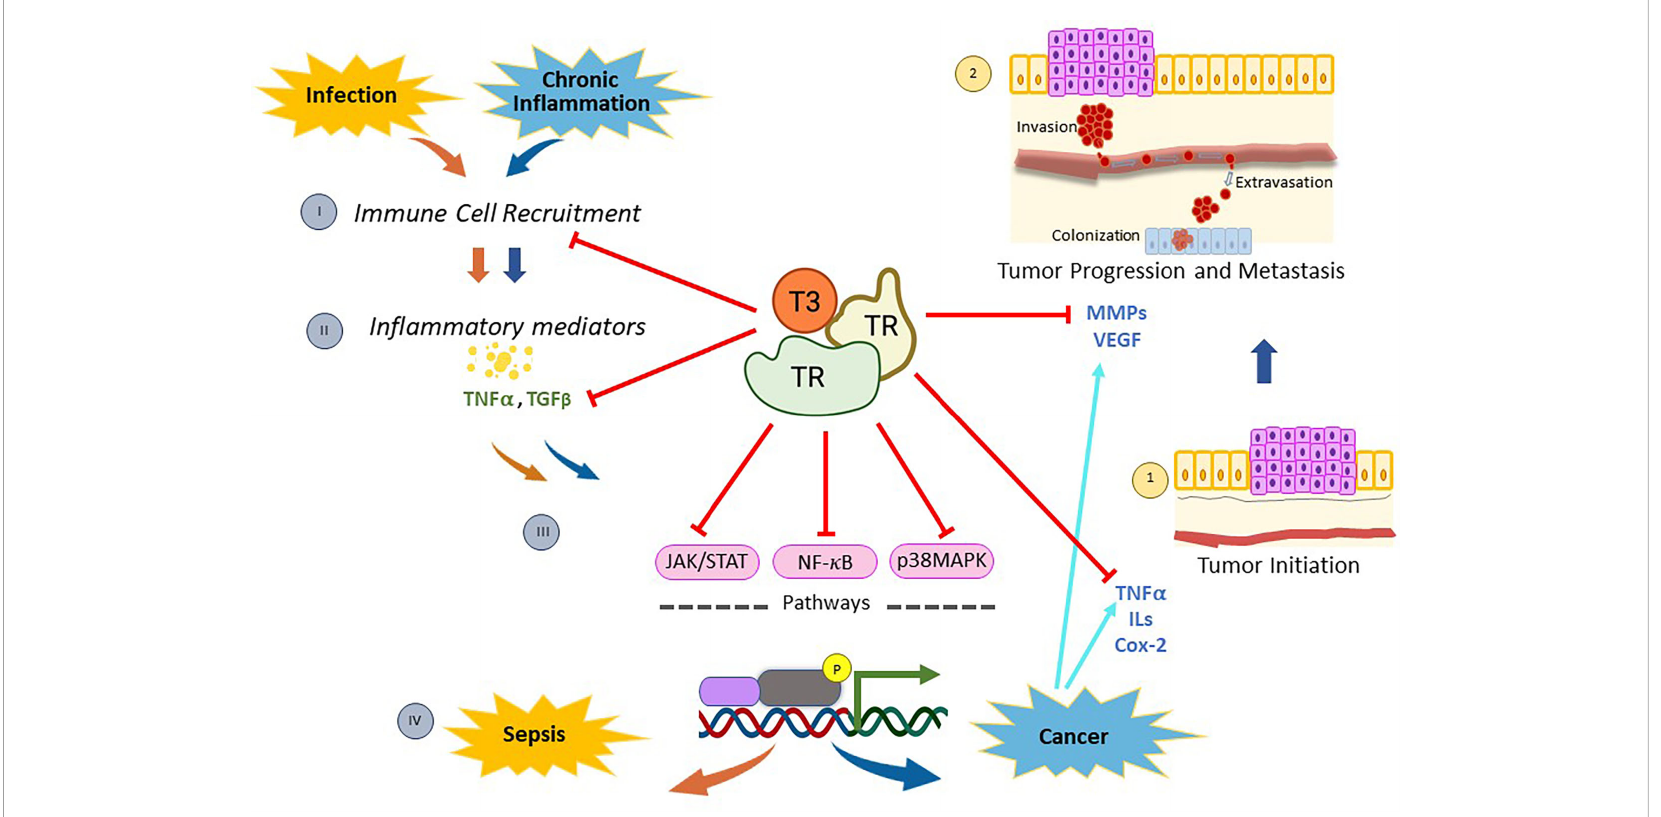
FIGURE 1 Mechanisms of action of thyroid nuclear receptors activated by T3 hormone on in fl ammation-related infection, and/or cancer. When pathogen infections occur, there is a recruitment of immune cells (I) that stimulate the synthesis and release of in fl ammatory mediators (II). Then, many of these molecules generate a genomic in fl ammatory response due to the activation of the signaling pathways mediated by NF-kB, p38MAPK, and/or JAK/STAT (III). If the infection persists, the host ’ s protective innate immunity is overactivated and a reaction called sepsis appears (IV). On the other hand, chronic in fl ammation is linked to diverse types of cancer through the production of in fl ammatory mediators (II), which activate the signaling pathways mentioned above (III) and induce the expression of several regulators of tumor initiation (1), progression and metastasis (2). Thyroid nuclear receptors (TRs) activated by T3 exert a protective role on both sepsis and cancer through several mechanisms. On one hand, TRs control the recruitment of immune cells and reduce the production of in fl ammatory mediators by down-regulating both NF-kB, p38MAPK and JAK/STAT pathways. In addition, TRs inhibit tumor initiation (1) by decreasing proliferation and inducing apoptosis through deregulation of expression of in fl ammatory mediators, such as TNF a and Cox-2. Moreover, TRs inhibit tumor progression and metastasis (2) by down-regulation of MMPs and/or VEGF. All these data demonstrate that T3 hormone through its binding to speci fi c nuclear receptors counteracts the in fl ammation associated with cancer and/or infection, opening new lines of research and drug development to improve current therapeutic interventions in those